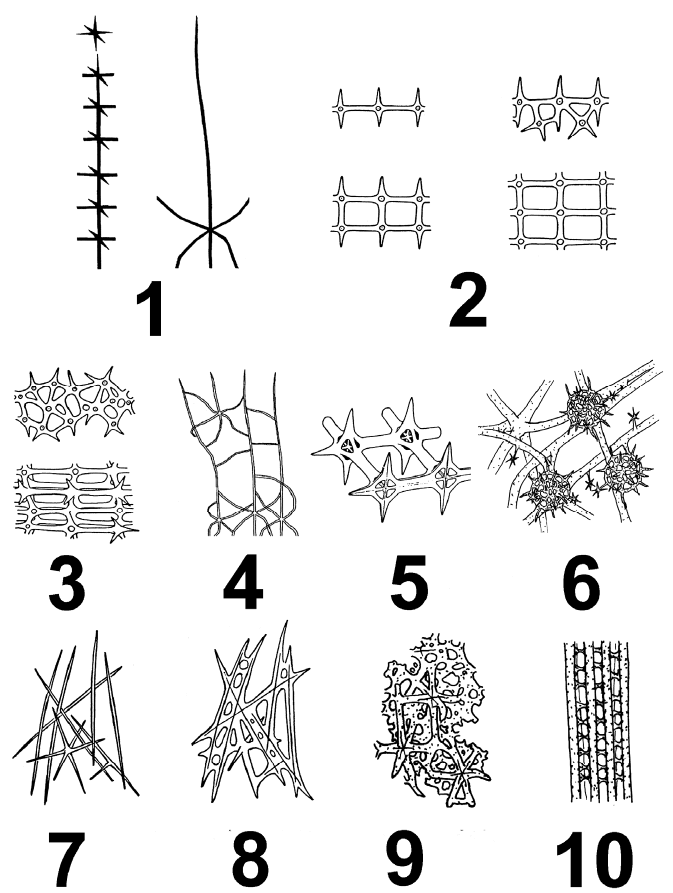
Figure 1. Types of skeletons of Hexactinellids: 1, 4—dictional strand, 2—farreoid, 3—euretoid, 5— aulocalicoid, 6—lychninisskosan, 7—fieldingioid, 8/9—lissacinosan (8—free skeleton, 9—fused form of free skeleton), 10—skeleton of the basal lamina, 11—skeleton of the base (pedoncle) (after [38]).